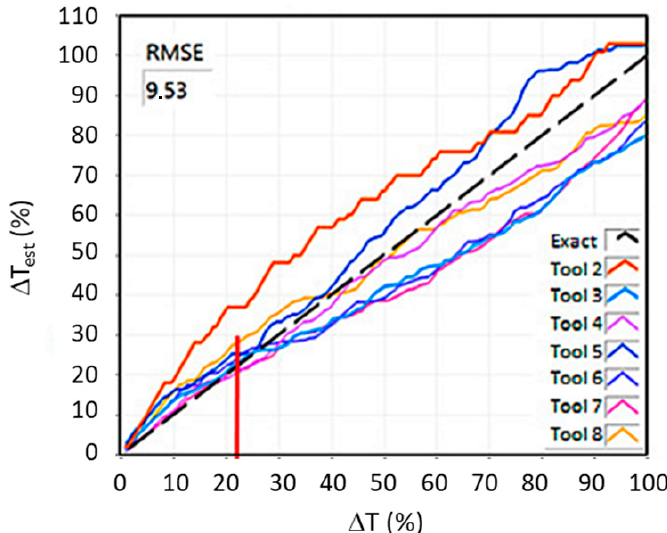
Figure 4. Results of the gradual tool wear estimation algorithm (GTW) [47].